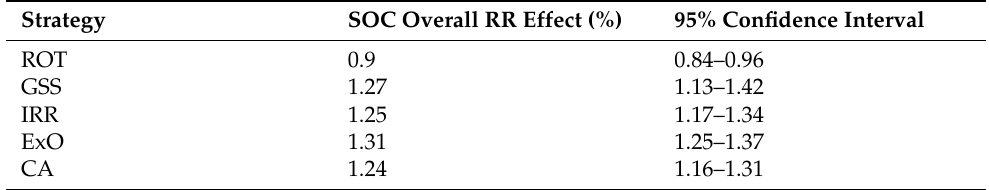
Table 2. Overall regional RR effect and 95% confidence interval on SOC for each strategy. Manage- ments are conservation agriculture (CA), addition of exogenous sources of organic C (ExO), rotations (ROT), irrigation (IRR), and controlled grazing and/or rotation in grasslands (GSS).